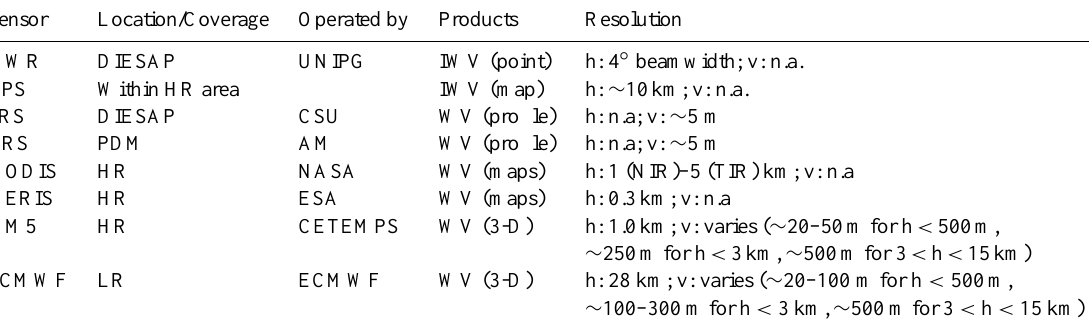
Table 1. Sources of measurements of WV distribution collected during the METAWAVE WVIOP in Rome. The letters “h” and “v” stand for horizontal and vertical resolution, respectively. Sensor Location/Coverage Operated by Products Resolution MWR DIESAP UNIPG IWV (point) h: 4 ◦ beamwidth; v: n.a. GPS Within HR area IWV (map) h: ∼ 10km; v: n.a. DIESAP CSU WV (profile)